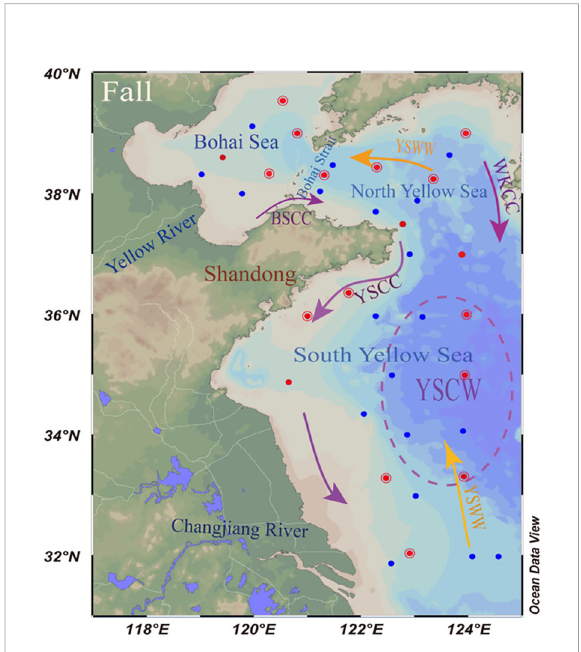
FIGURE 1 Study area and sampling sites in the Bohai Sea (BS) and Yellow Sea (YS) between 18 October and 4 November 2021. Temperature, salinity, DO, inorganic nutrients, Chl- a and dMo concentrations in surface and bottom seawater at all stations (blue + red) were determined. N 2 - fi xation rates at 14 stations (red hollow circles) and 16s rRNA at 18 stations (red solid dots) were measured in surface seawaters. In autumn, the circulation schematic includes the Bohai Sea Coastal Current (BSCC), Yellow Sea Coastal Current (YSCC), Western Korean Coastal Current (WKCC) and Yellow Sea Warm Water mass (YSWW). The Yellow Sea cold water (YSCW) is located in the dashed